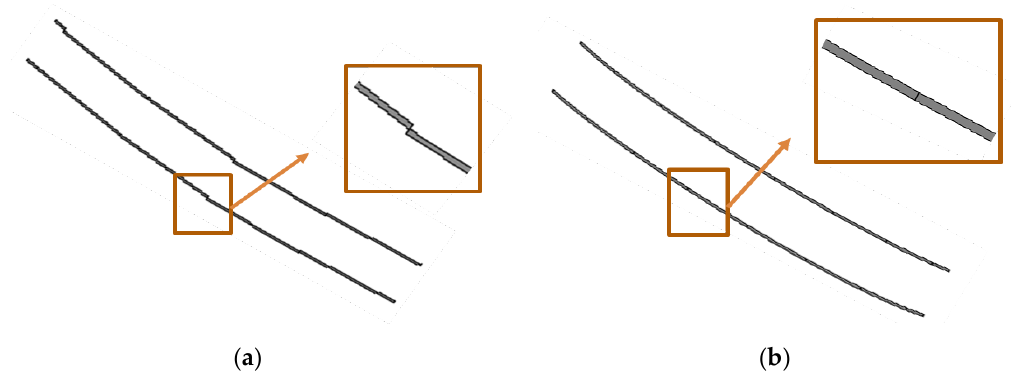
Figure 2. The 3D model of rail track 1 with ( a ) initial parameters and ( b ) interpolated parameters.